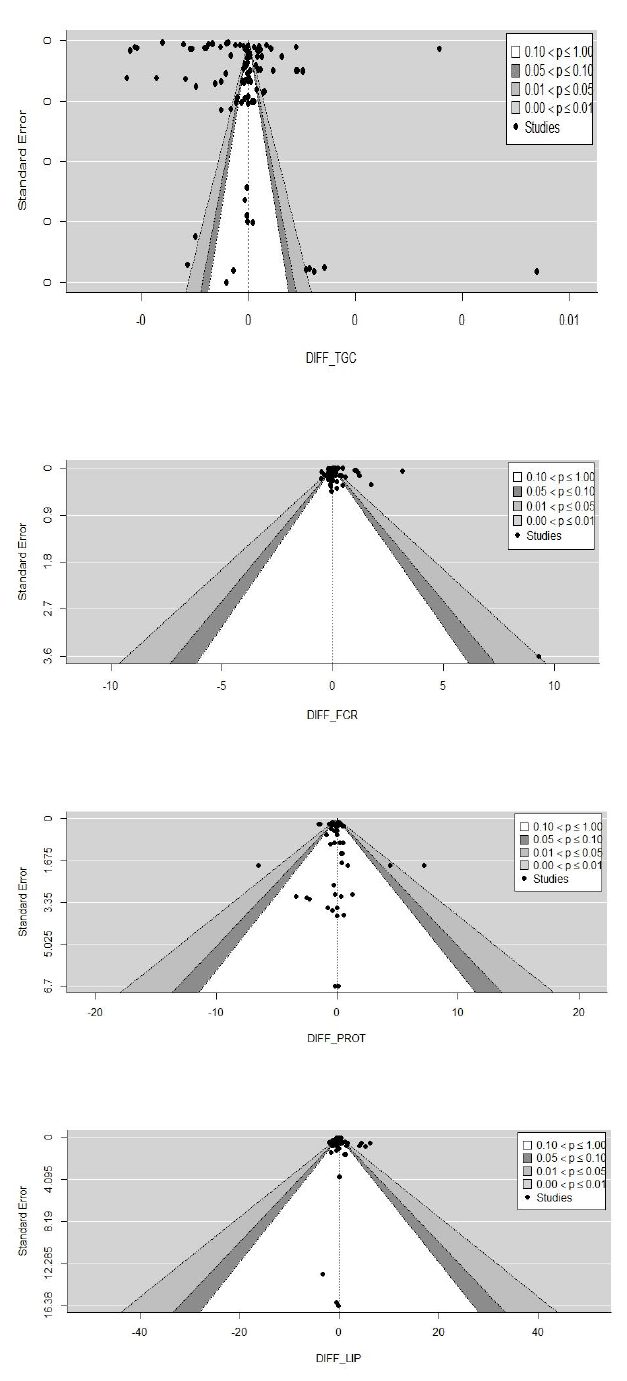
Figure 4. Funnel plots of differences in means between experimental and control groups. For each funnel plot, the null hypothesis is rejected outside the white and dark grey areas ( p < 0.05). This could imply that the effect of experimental diets on fish growth and nutritional parameters would not be significantly different from the